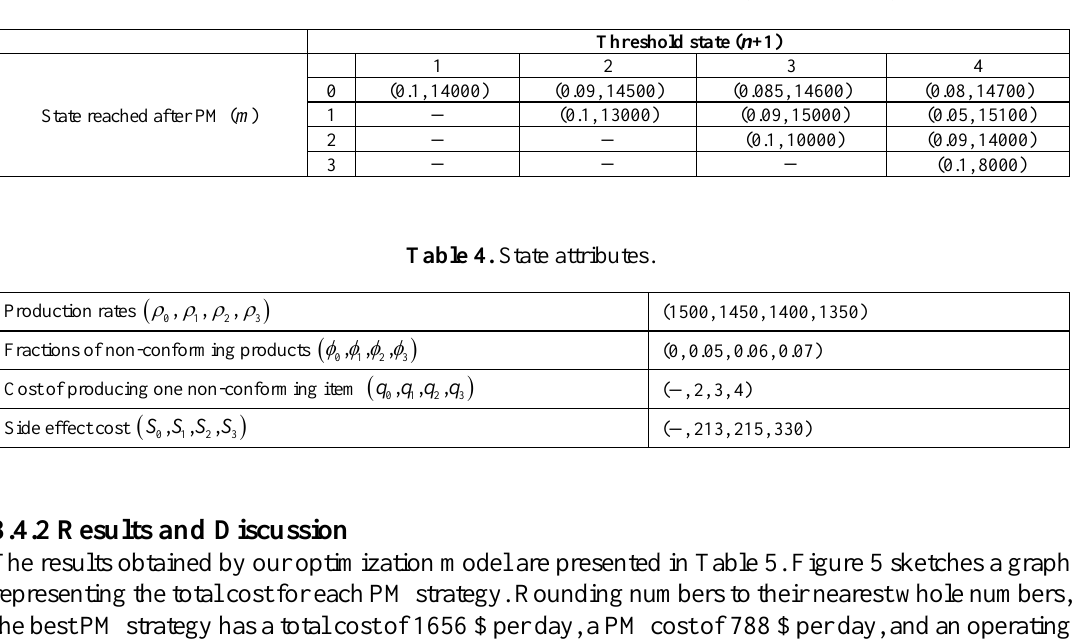
Table 3. PM transition rates with the corresponding costs: